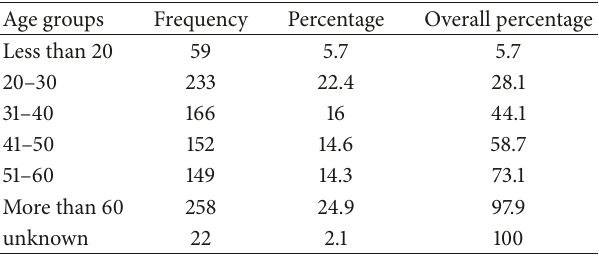
Table 1: Frequency distribution of age groups in the studied cases.